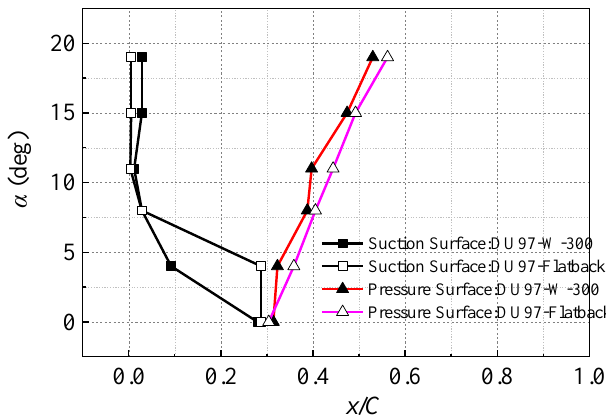
Figure 12. Location of transition on the suction and pressure surfaces of the airfoils.